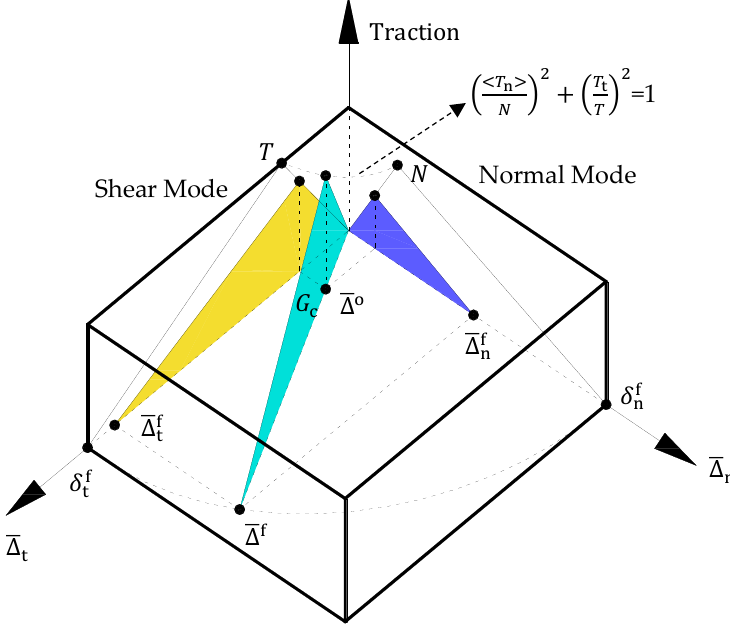
Figure 3. Mix-mode damage criterion.